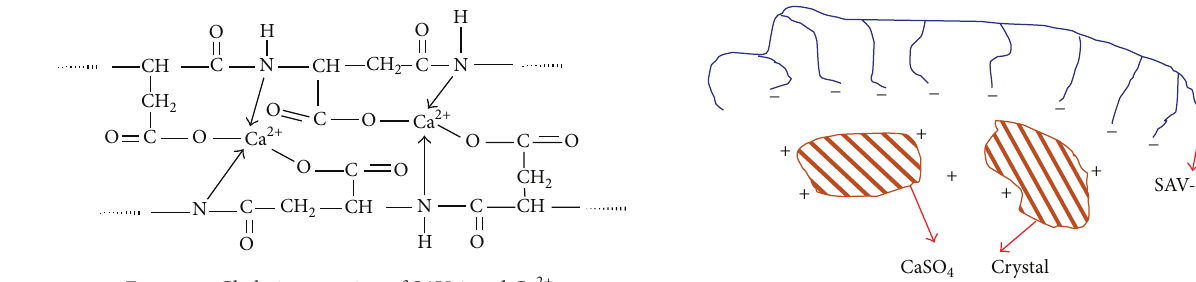
Figure 7: Chelating reaction of SAV-2 and Ca 2+ .